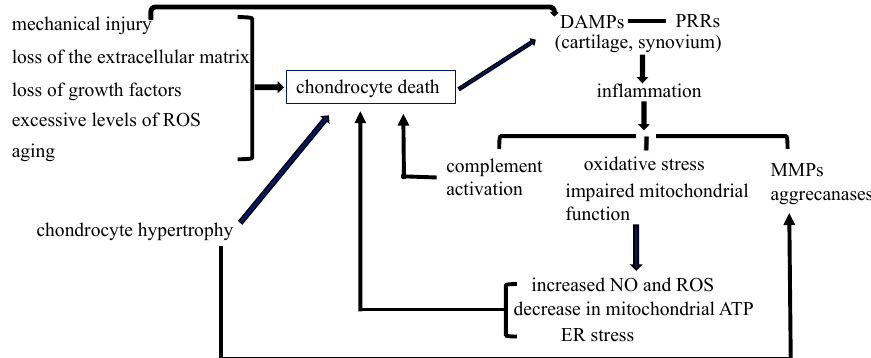
Figure 1. Chondrocyte death in osteoarthritis. Mechanical injury, the loss of the extracellular matrix, loss of growth factors, and excessive levels of reactive oxygen species (ROS) induce chondrocyte death in articular cartilage. Chondrocyte hypertrophy in articular cartilage induces the destruction of the cartilage matrix through the induction of matrix metalloproteinases (MMPs) and aggrecanases, and leads to chondrocyte apoptosis. The number of dead chondrocytes also increases in articular cartilage during aging. DAMPs (danger-associated molecular patterns) released by mechanical injury and chondrocyte secondary necrosis initiate non-infectious inflammatory responses through PRRs (pattern recognition receptors) expressed in osteoarthritis (OA) cartilage and the synovium, causing complement activation, oxidative stress, impaired mitochondrial function, and the induction of MMPs and aggrecanases. Complement activation, an increase in nitric oxide (NO) and ROS, a decrease in mitochondrial ATP, and endoplasmic reticulum (ER) stress further enhance chondrocyte death, resulting in the progression of osteoarthritis. The contribution of chondrocyte death to inflammatory processes needs to be evaluated. The inflammatory processes induced by mechanical injury contribute to the development of posttraumatic OA; however, their significance in non-posttraumatic OA remains unclear.